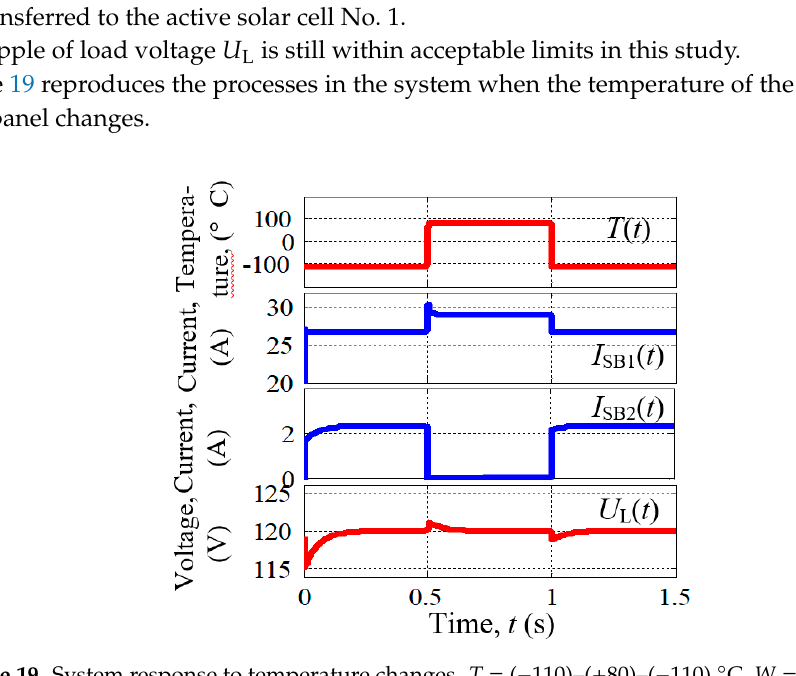
Figure 19. System response to temperature changes. T = ( − 110)–(+80)–( − 110) ° С . W =1000 W/m 2 . Analysis of Figure 19 confirms the automatic transfer of control between the solar panels. At low temperatures, the first solar panel cannot provide the full current I L = 29 A, and the load is distributed across two solar panels, I SB1 ≈ 27 A, I SB2 ≈ 2